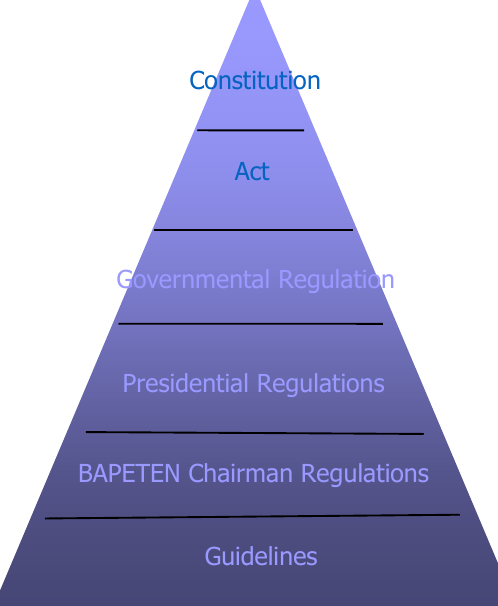
Figure 2. Hierarchy of legislation and